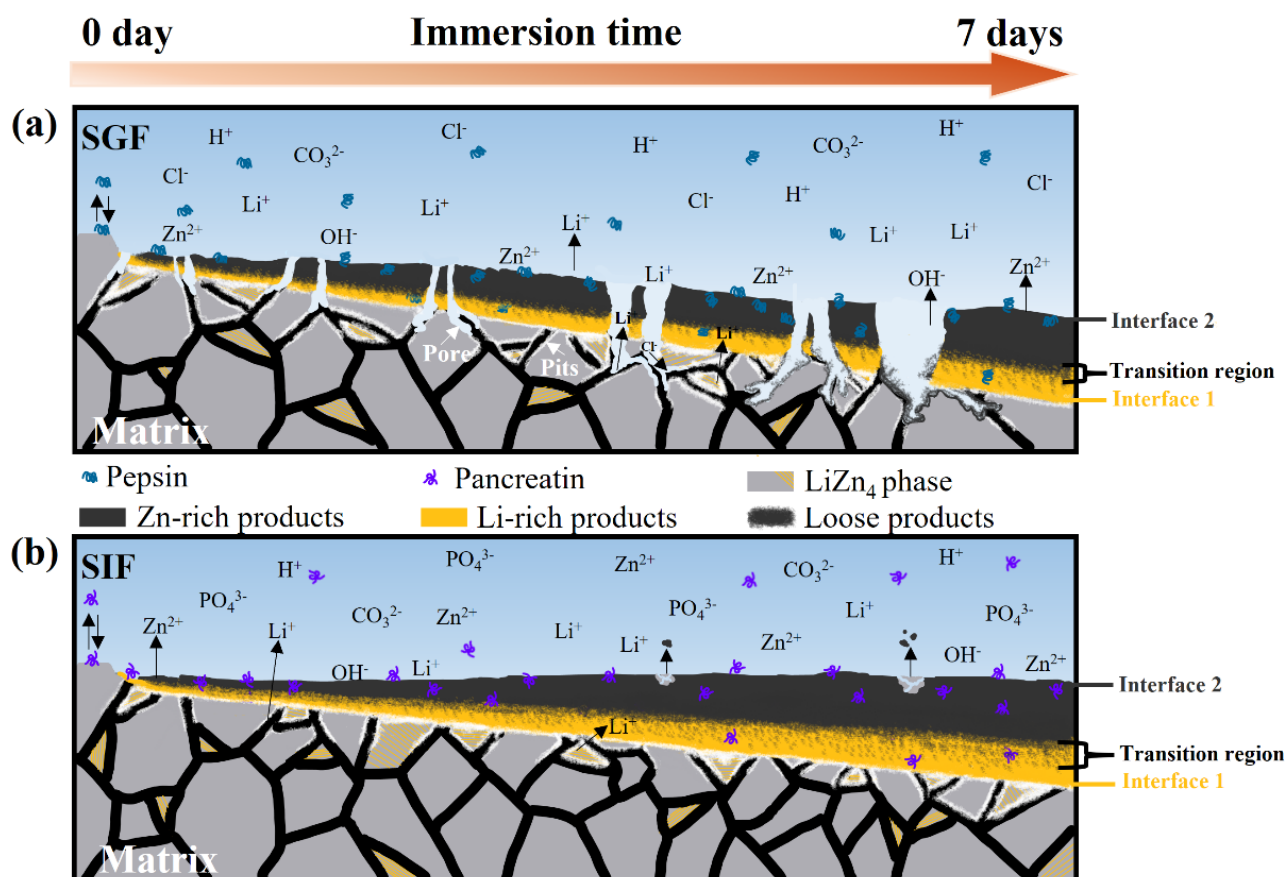
Figure 11. Schematic illustration of Zn–0.4Li alloy degradation in different solutions as the immersion time increases. ( a ) Degradation in SGF and ( b ) degradation in SIF.